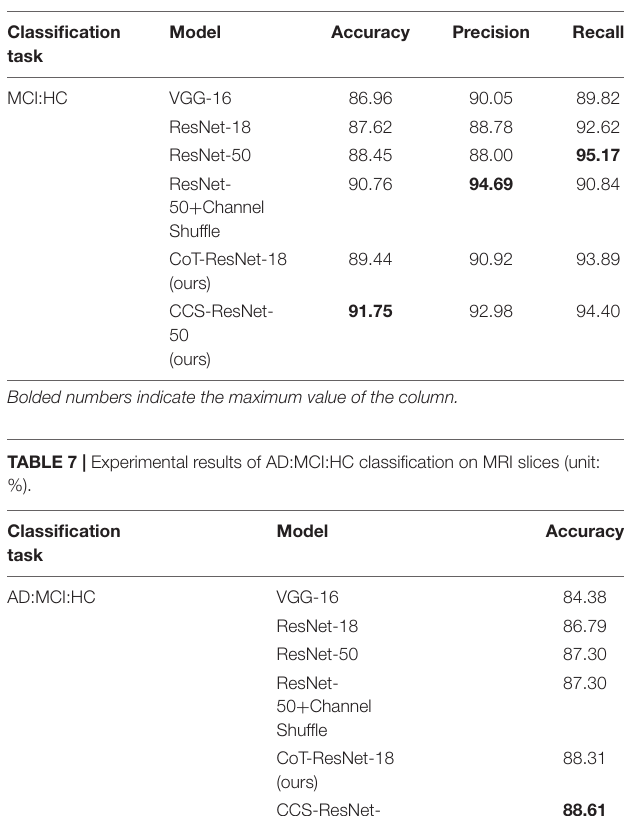
TABLE 6 | Experimental results of MCI:HC classification on MRI slices (unit: %). Classification task